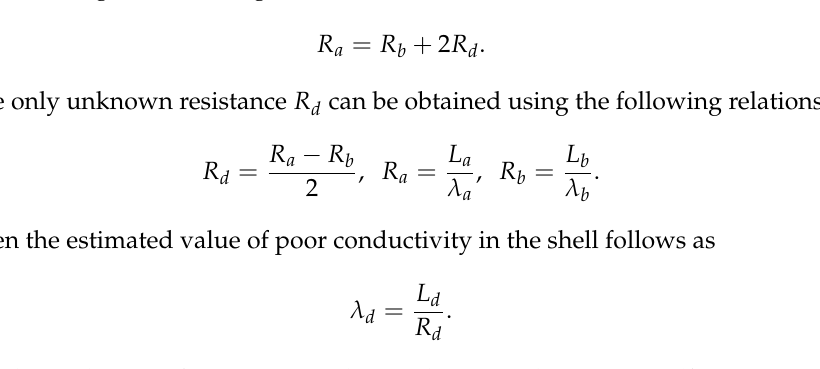
Figure 7. Internal structure along the height of a fractured fin of the heat sink prototype ( left ) with highlighted flakes’ orientation ( right ). The region where the flakes’ orientation transitions from a parabolic structure to par- allel lines is considered as the core-shell interface (represented by the red dashed line in Figure 7). The core and shell dimensions were obtained from a graphics software after manually specifying the core-shell interface. The values used to create the numerical model of the composite heat sink are averaged from several photographs. The dimensions were determined separately for the heat sink’s base and the fins.